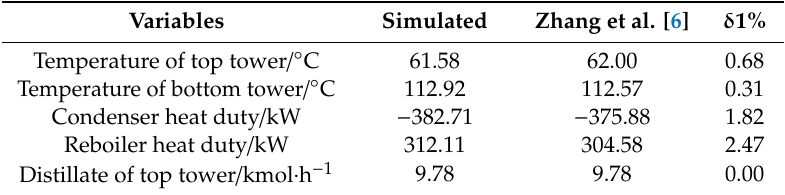
Table 2. Comparison of the simulation results of Example 1.